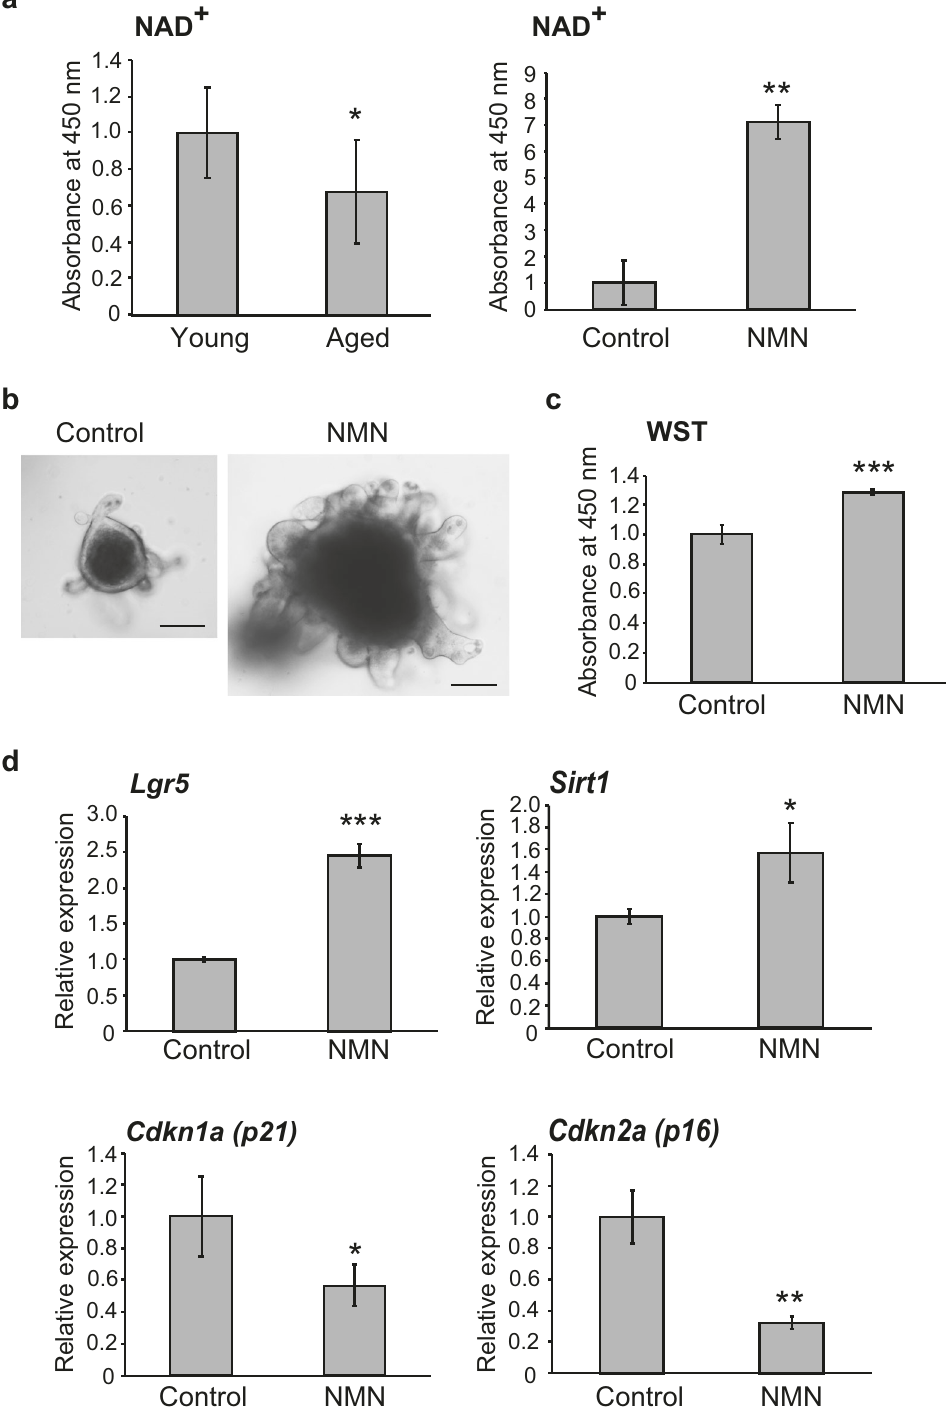
Fig. 4 Effect of NMN on senescence of intestinal epithelial organoids from aged mice. a NAD + levels of organoids derived from intestinal epithelia of young (7 weeks) and aged (55 weeks) mice (left). NAD + levels of intestinal epithelial organoids derived from aged (76 weeks) mice with or without NMN treatment (right). Results of 8 experiments were plotted as mean ± SD. * p < 0.05, ** p < 0.01. b Representative images of intestinal epithelial organoids derived from aged (76 weeks) mice with or without NMN treatment for 7 days. Scale bars: 100 μ m. c WST cell proliferation assay of intestinal epithelial organoids derived from aged (76 weeks) mice with or without NMN treatment for 10 days. Results of 8 experiments were plotted as mean ± SD. *** p < 0.001. d Relative expression levels of Lgr5, Sirt1, p21 , and p16 in intestinal epithelial organoids derived from aged (76 weeks) mice with or without NMN treatment. Results of 5 experiments were plotted as mean ± SD. * p < 0.05, ** p < 0.01, *** p <